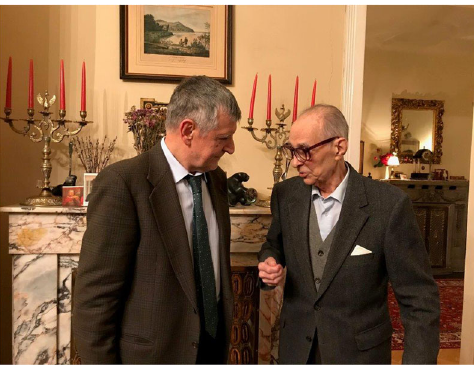
Fig. 3 Luigi Zecca and Oleh Hornykiewicz. Luigi Zecca discussing with Oleh Hornykiewicz in his house in Vienna, the 3 rd December 2019. Photograph by Christian Pi fl